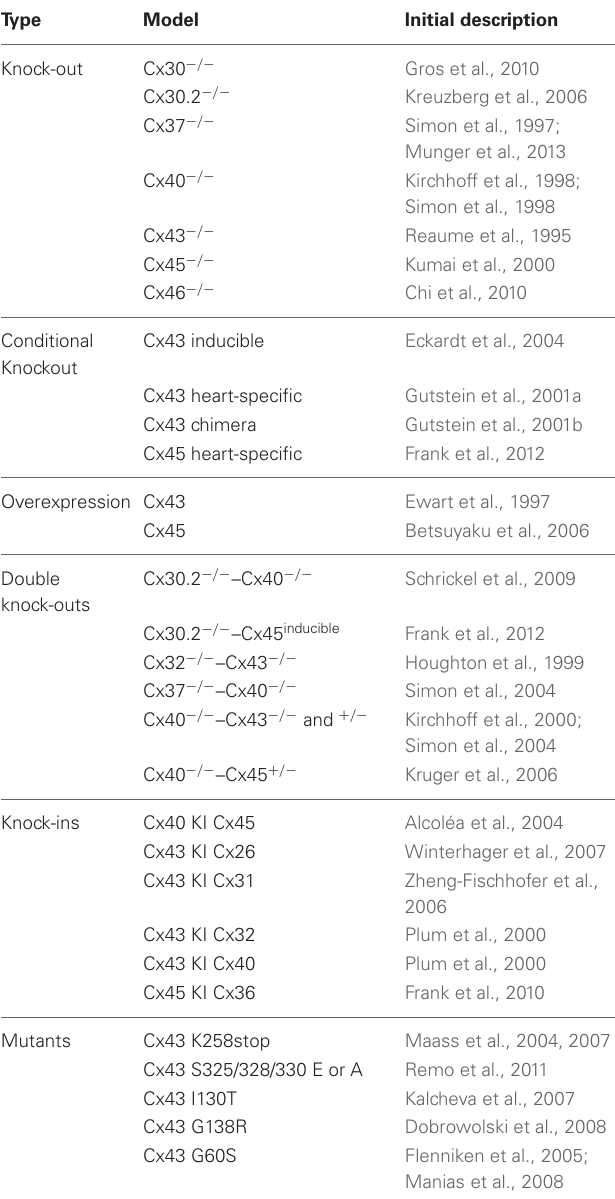
Table 2 | Overview of genetically engineered mouse